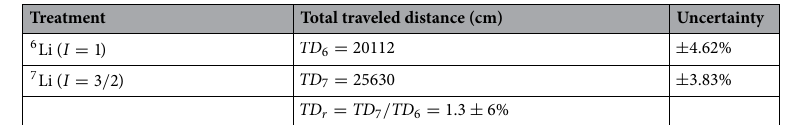
Table 1. Li isotopic nuclear spins and total traveled distance in 60 min for respectively, taken form the work of Ettenberg et al. 11 . TD r is the total traveled distance ratio.